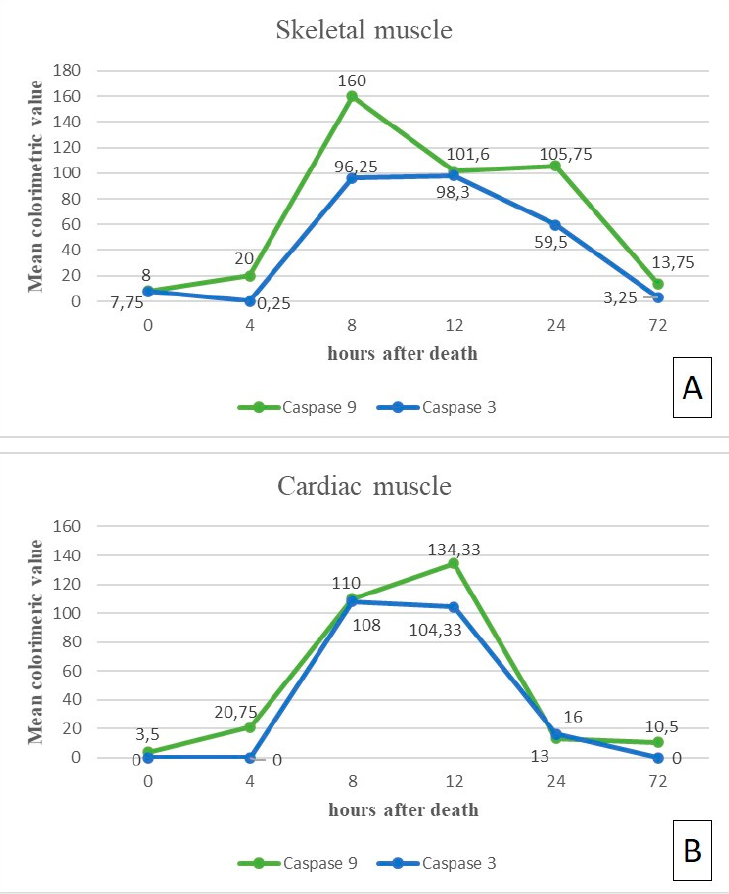
Figure 2. Graphs showing the medium value of immunopositivity observed at each time point for Caspase 9 and Caspase 3 respectively in skeletal muscle ( A ) and cardiac muscle ( B ): the skeletal muscle reactivity reveals an earlier pick of expression at 8 h, followed by a more gradual decrease of immunostaining, showing plateau stages at 8–12 h and 12–24 h respectively for Caspase 3 and Caspase 9; the reactivity in heart tissue shows an higher expression of Caspase 9 and 3 at 12 h, followed by an abrupt decrease and a plateau stage between 24 and 72 h.